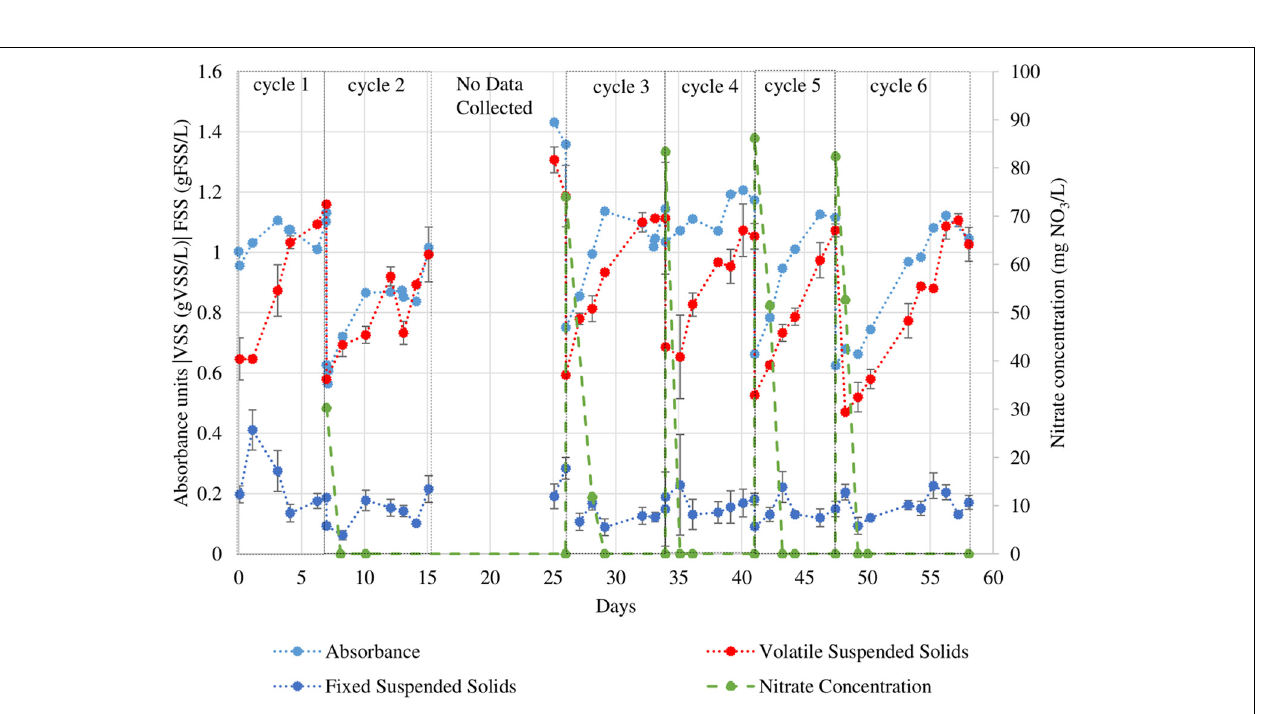
Frontiers in Marine Science |